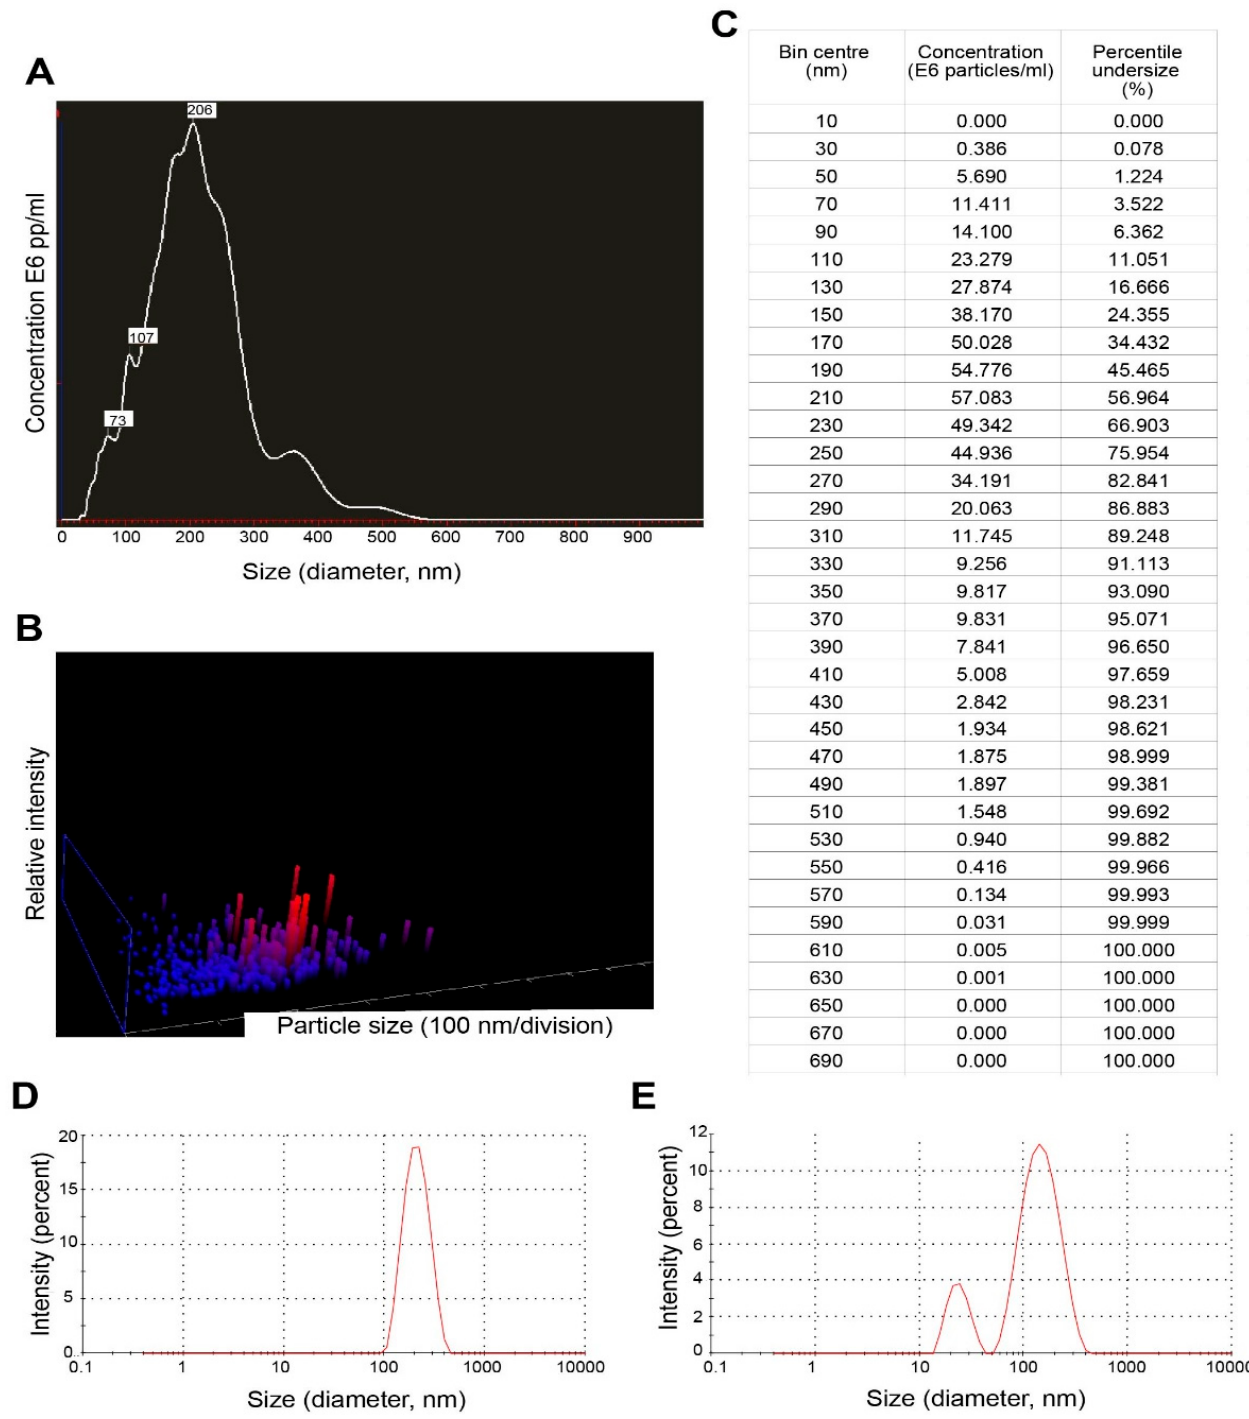
Figure 3. Nanoparticle tracking analysis and dynamic light scattering results of extracellular vesicles secreted by trophozoites of Naegleria fowleri: ( A ) Graph showing sizes and relative concentration of the vesicles using NTA; ( B ) 3D plot of particle size/relative intensity using NTA and ( C ) table of concentration of particles of different sizes obtained during the NTA analysis. ( D ) Graph showing the size of EVs from the pellets using DLS and ( E ) graph showing size of EVs from the remaining supernatant (after the washing steps) using DLS.